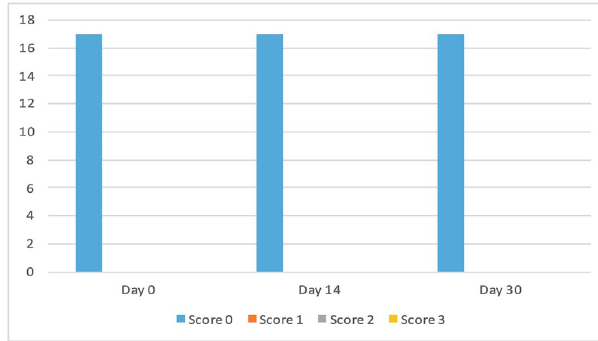
Figure 5. Number of cats according to the clinical score for hair loss in Group 2 (Frontline Combo (cid:1) ).